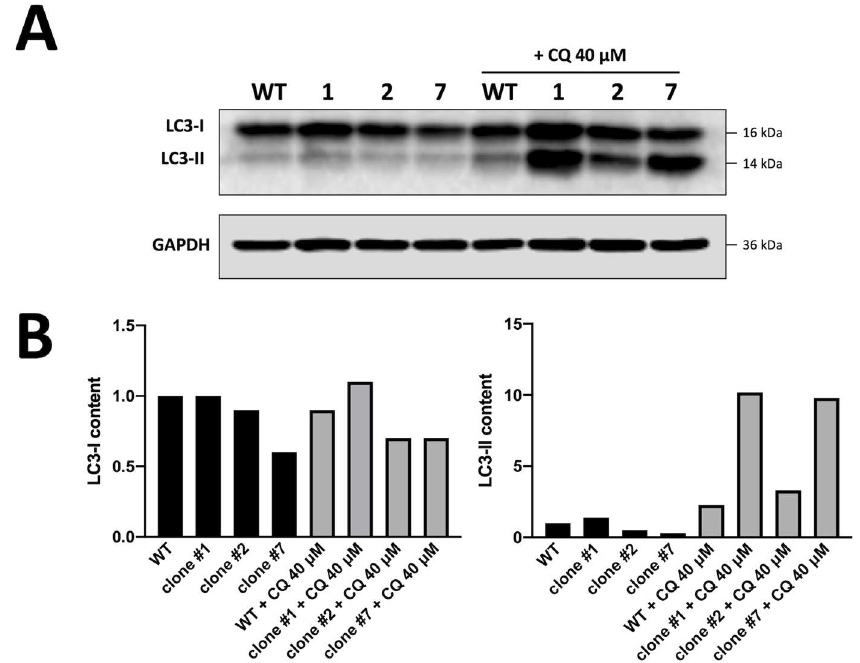
Figure 5. Western blotting experiment performed on clones 1, 2 and 7 (the producers of higher amounts of α-globin protein) and validating data obtained with FACS analysis; we employed chloroquine clamping for 48 h to better show autophagic flux ( A ). Summary showing LC3-I and LC3-II content in K562 WT cells vs. in clones 1, 2 and 7 when CQ was added for 48 h. LC3-II protein levels increased in obtained clones with respect to WT cells, confirming a higher number of autophagic vesicles, as founded by FACS analysis ( B ).